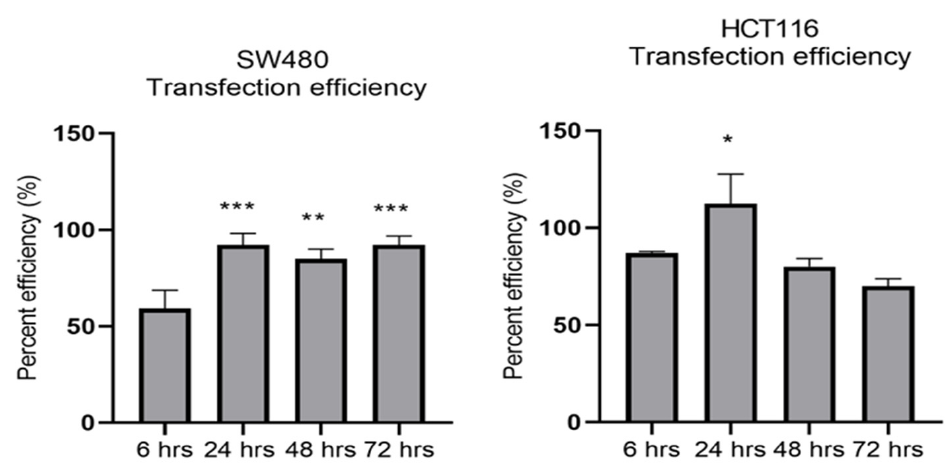
Figure 3. Optimal time for transfection efficiency (TE). FAM dye ‐ labelled synthetic scrambled miRNA control transfected with Lipofectamine RNAiMAX in SW480 and HCT116 cells. Transfected FAM dye ‐ labelled miRNAs was measured by a plate reader at emission 520 nm and excitation 495 nm. Significant difference was calculated using one ‐ way ANOVA with Dunnett’s test comparing to 6 h (the earliest time point) (GraphPad Prism 8, * p < 0.05, ** p < 0.01, *** p < 0.001). Data are presented as a mean percentage of efficiency. Error bars represent the SEM for six replicates and two independent cultures.